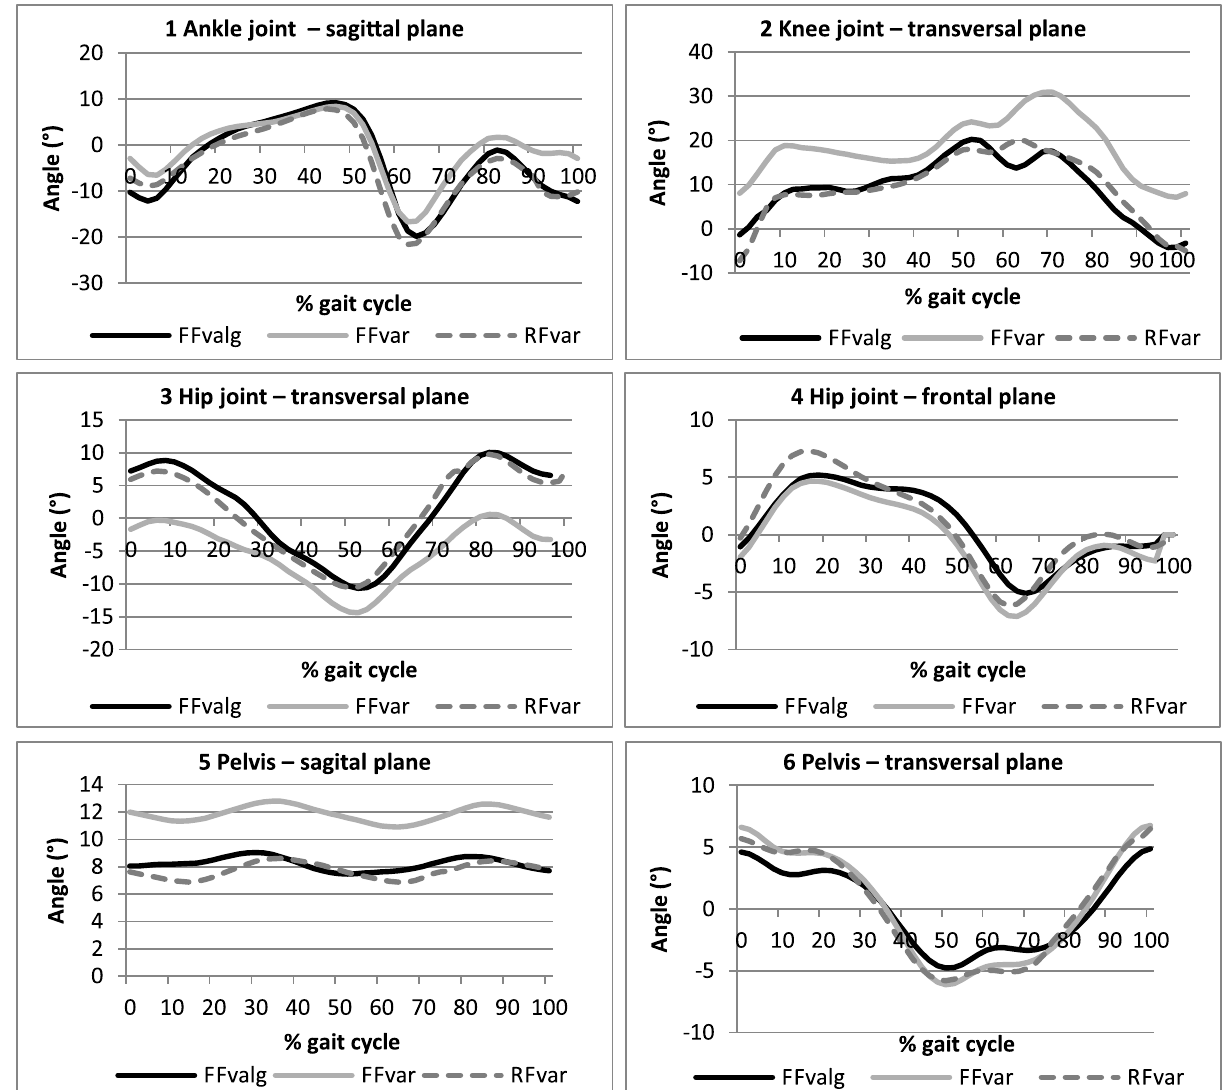
Figure 1. Graphical representation of mean values of kinematic parameters of the lower extremity joints and pelvis during walking in different foot types. FFvalg = forefoot valgus; FFvar = forefoot varus; RFvar = rearfoot by the forefoot in relative supination to the rearfoot (Tiberio, 1988). The main strategy of compensatory mechanisms for FFvar lies in the extended or exces- sive pronation during mid and final stance phase with compensated forefoot varus. For the uncompensated variant of FFvar the medial midfoot portion remains without contact with the ground and thereby, the concentration of weight at the lateral edge of the sole lasts until the heel strike (Vařeka & Vařeková, 1999). Our study did not confirm these combined movements kinematic parameters in ankle joint (AJ) in the trans- verse plane, but we found differences in the upper seg- ments, at the level of the pelvis and hip joint. Accord- ing to theoretical knowledge of kinematic chains,